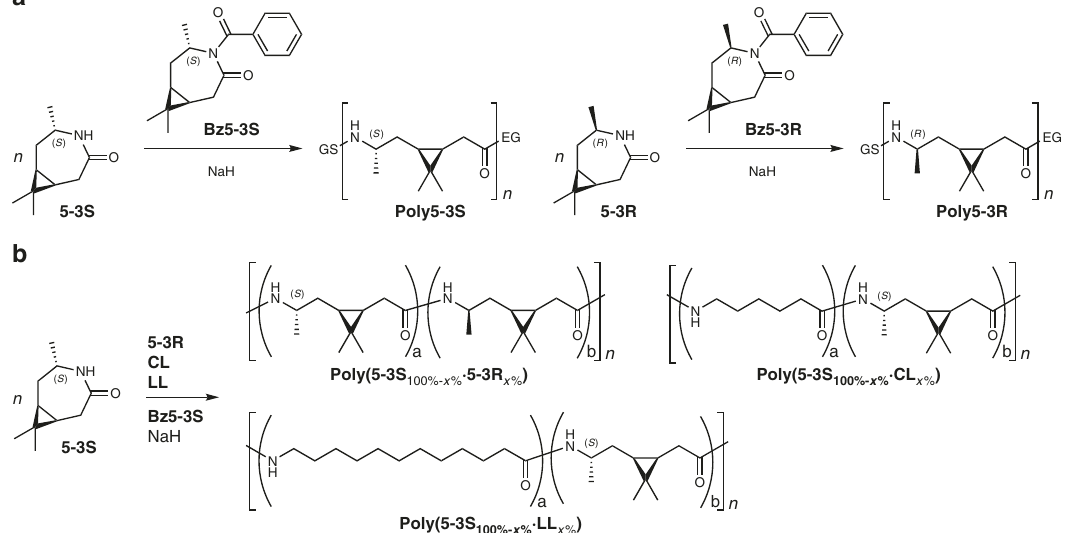
Fig. 3 Polymerization overview. Anionic ring-opening polymerization of the ( + )-3-carene based lactams 5-3S and 5-3R ( a ) and co-polymers of the general structures poly(5-3S 100% − x % ·5-3R x % ) from 5-3S and 5-3R , poly(5-3S 100% − x % ·CL x % ) from 5-3S and CL, and poly(5-3S 100% − x % ·LL x % ) from 5-3S and LL ( b ).